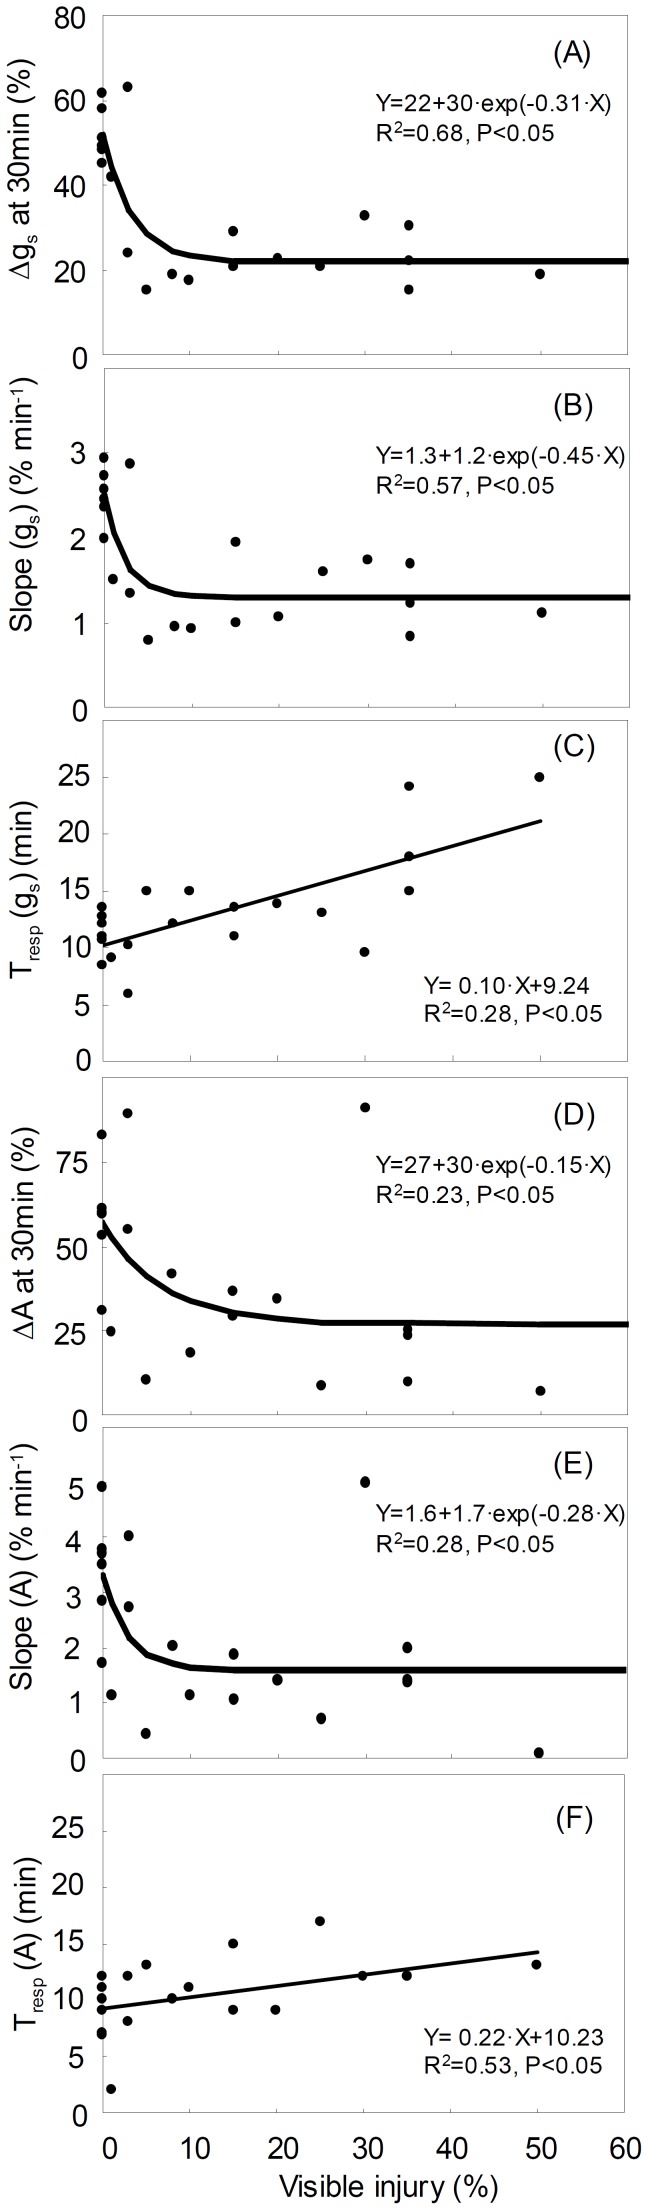
Relationships between visible ozone foliar injury and dynamic response of stomatal conductance (gs) and photosynthesis (Amax) over 30 min after leaf severing (A: Δgs at 30 min; B: Slope(gs); C: Tresp (gs); D: ΔA; E: Slope(A); F: Tresp (A)).